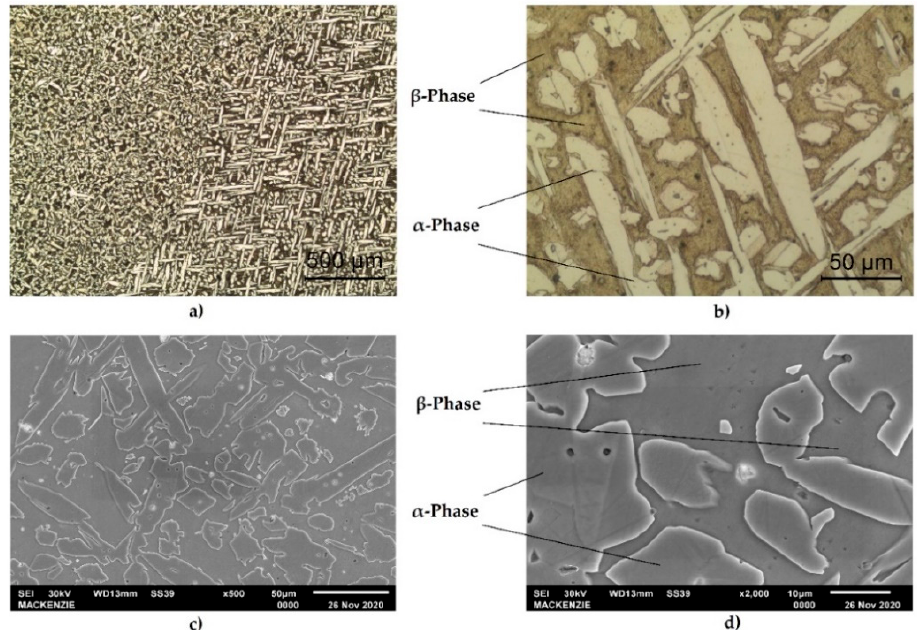
Figure 3. Optical micrograph showing the microstructure of the UNS C67600 alloy after cold worked and heat treatment at 650 ◦ C ( a ) α -phase needles (light areas) are present in the dark β -phase. ( b ) Detail of ( a ), dark particles of Pb and lighter particles of Fe are present. ( c ) SEM micrograph showing the α -phase in the dark β -phase. ( d ) Detail of ( c ).